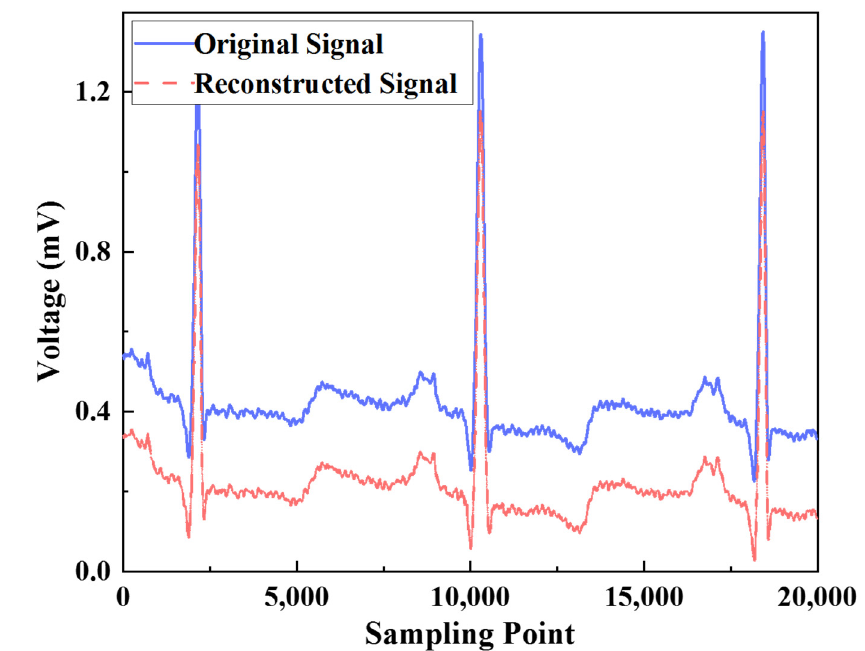
Figure 13. The reconstruction results of the compressed data.